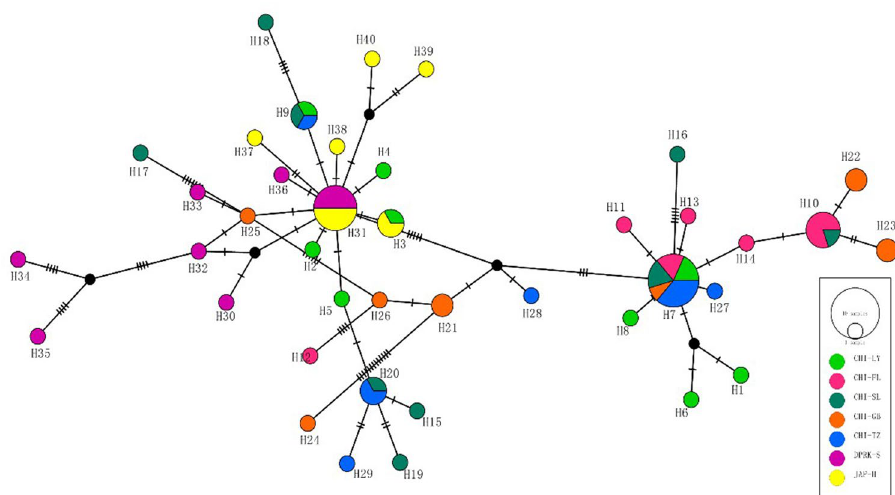
Figure 2. The phylogenetic network otained using the MJ algorithm shows the evolutionary relationships of the COI sequences in this study 13 . The color of the sector indicates the haplotype frequency in the seven populations studied. The size of the circle is proportional to the haplotype